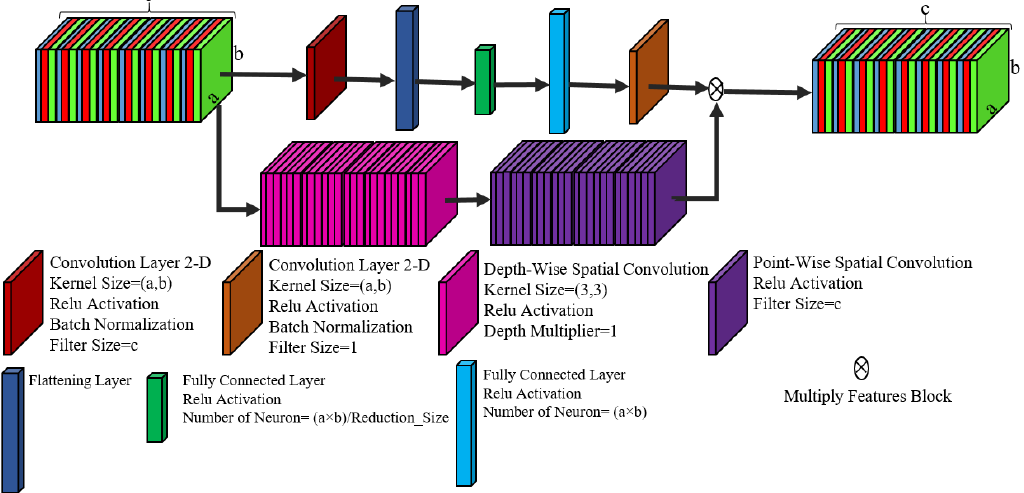
Figure 5. The proposed spectral attention